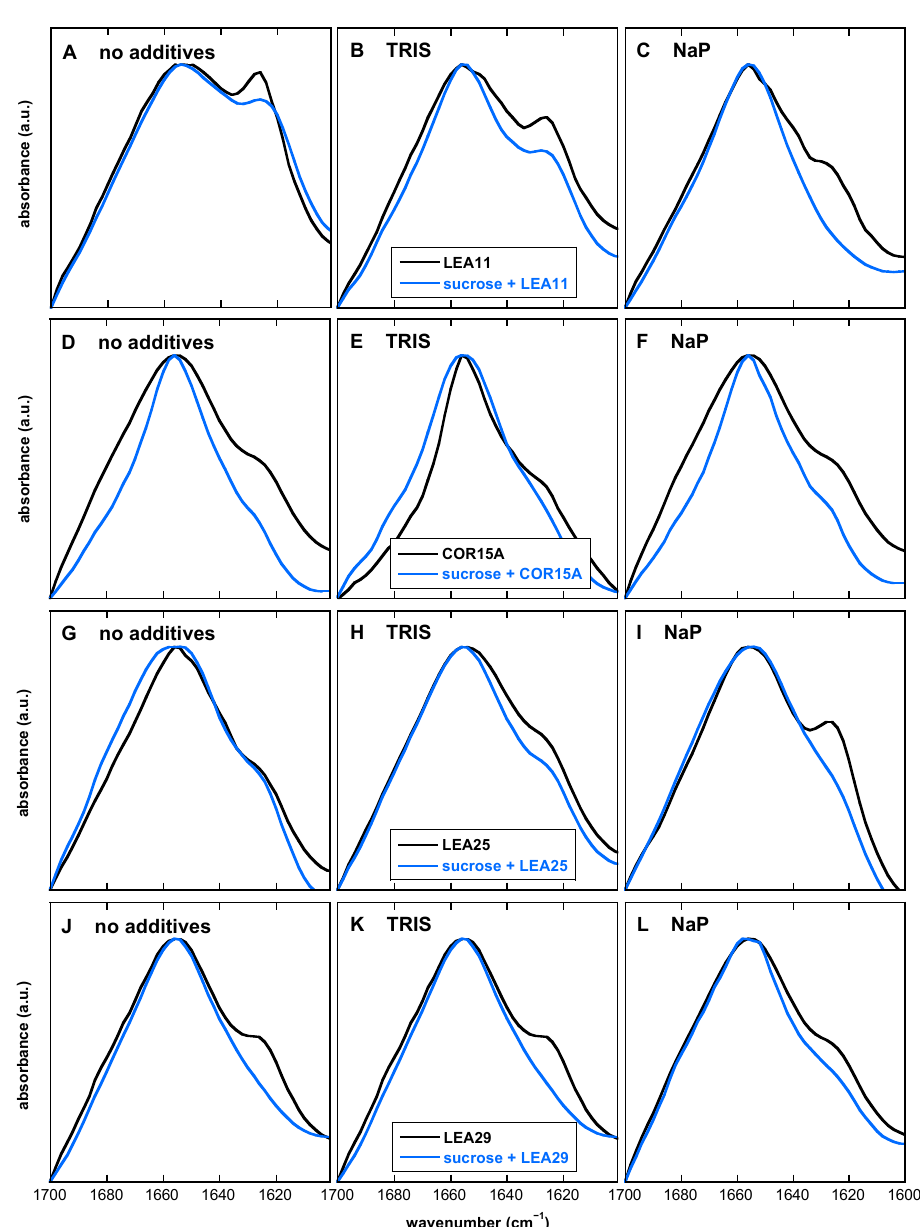
Figure 11. Normalized amide I peaks from FTIR spectra of dry LEA11 ( A – C ), COR15A ( D – F ), LEA25 ( G – I ) and LEA29 ( J – L ). Samples contained the LEA proteins in the absence or presence of Suc at a mass ratio 2 in H 2 O (no additive) ( A , D , G , J ), 10 mM Tris ( B , E , H , K ), or 10 mM NaP (pH 7.4) ( C , F , I , L ) as indicated in the panels. Samples were dried on CaF 2 windows, and spectra were recorded at 30 °C.